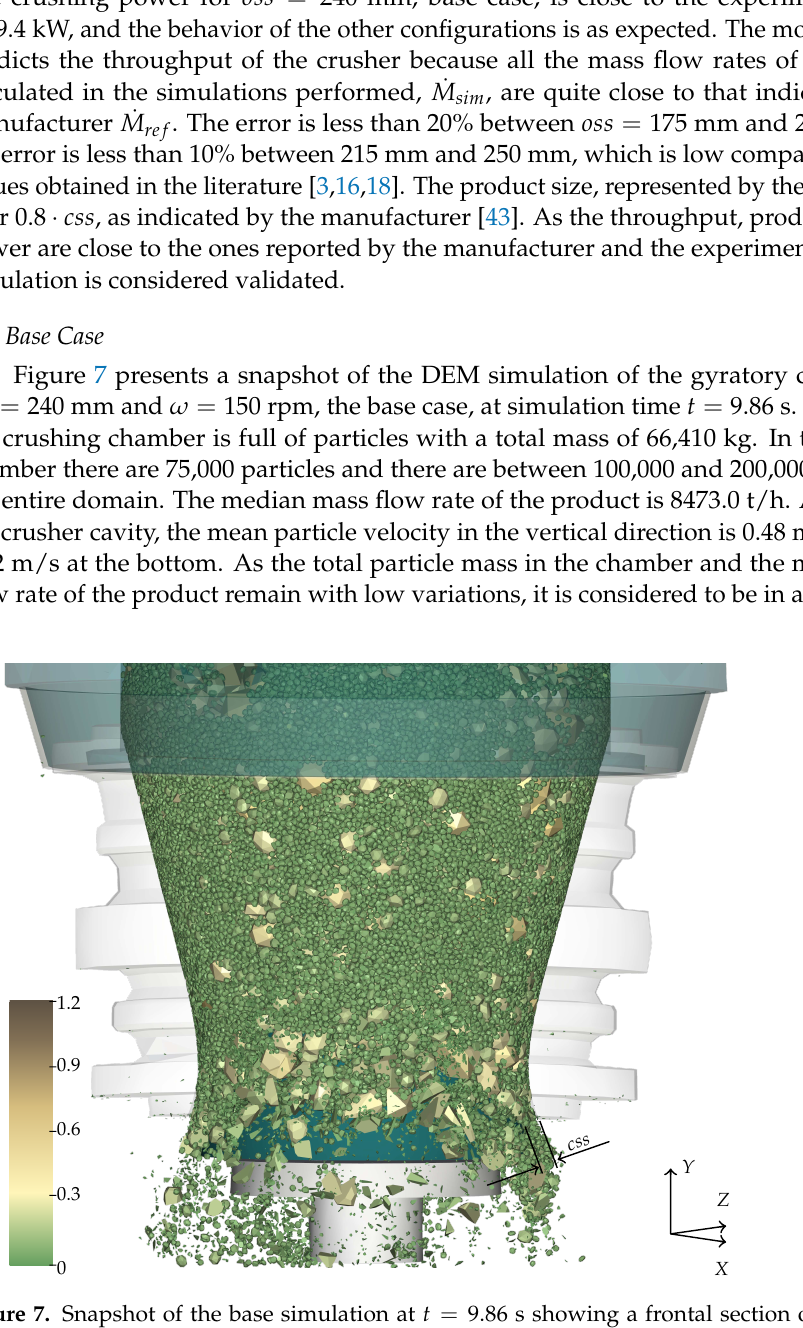
Figure 7. Snapshot of the base simulation at t = 9.86 s showing a frontal section of the crusher. The particles are colored by their particle size, and the concave was cut to observe the particles. The position of the closed side setting, css , is also